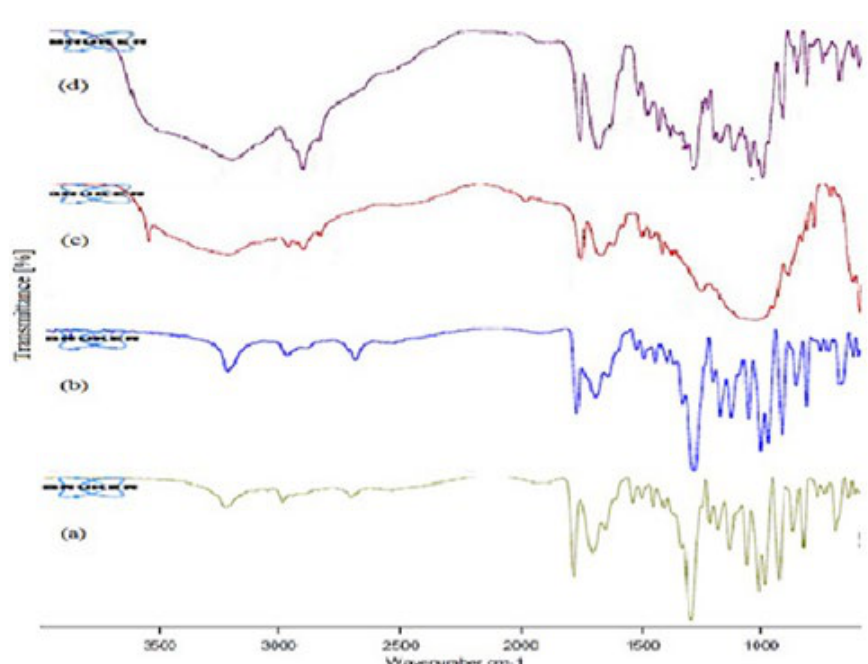
FIGURE 1 - FT – IR spectra of (a) Pure TDF; (b) Physical mixture of TDF and PLGA RG503H; (c) Physical mixture of TDF and PLGA RG502H; (d) Physical mixture of TDF and PLA